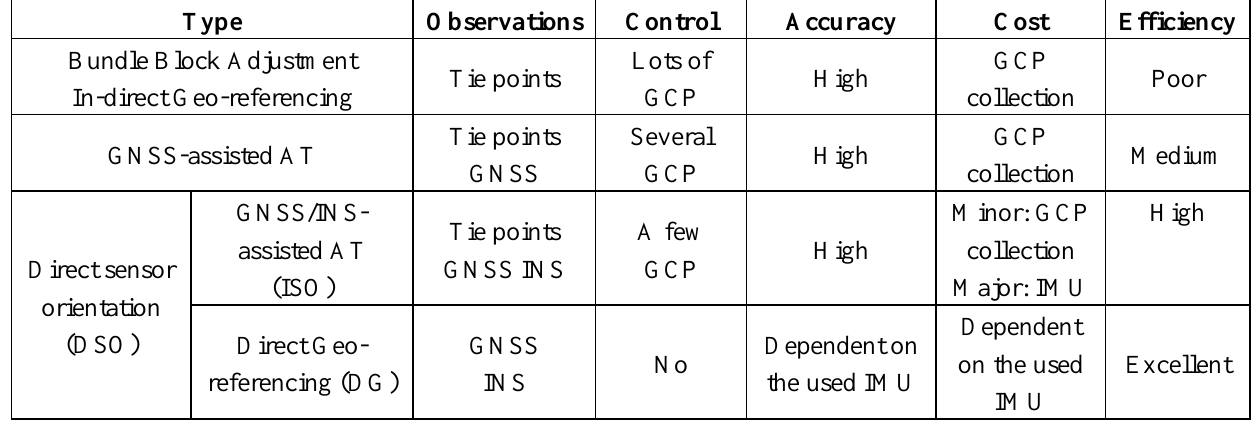
Table 1. The comparison of sensor orientation